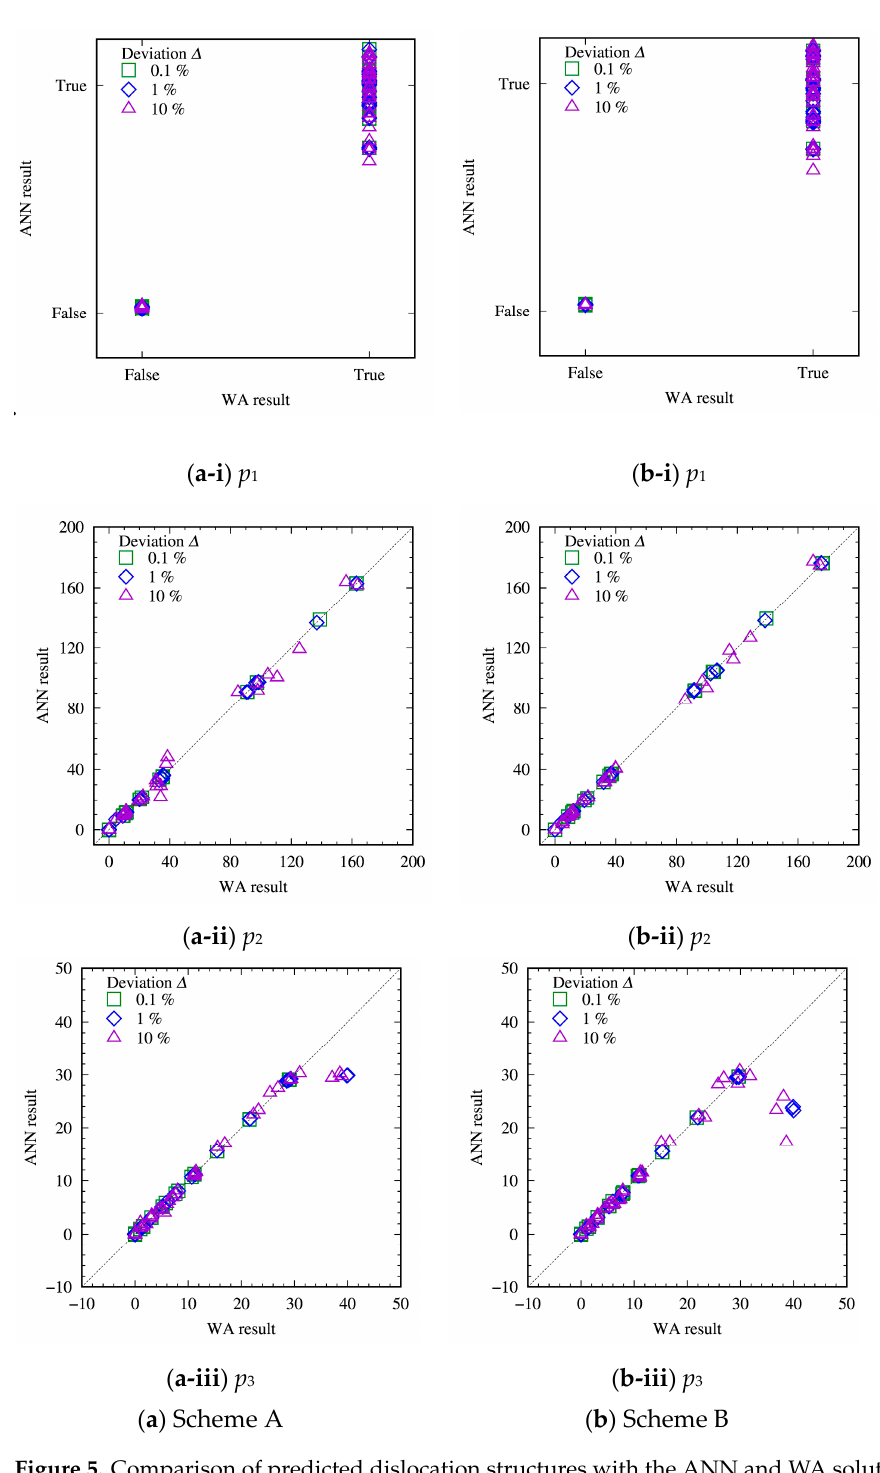
Figure 5. Comparison of predicted dislocation structures with the ANN and WA solutions for the deviated parameter sets of ( a ) Scheme A and ( b ) Scheme B. (i), (ii) and (iii) show Boolean values representing whether a dislocation wall structure is formed, p 1 , the number of walls, p 2 , and the average width of the formed walls, p 3 , respectively. The square, diamond and triangle plots show the amount of deviation Δ = 0.1, 1, and 10%, respectively.